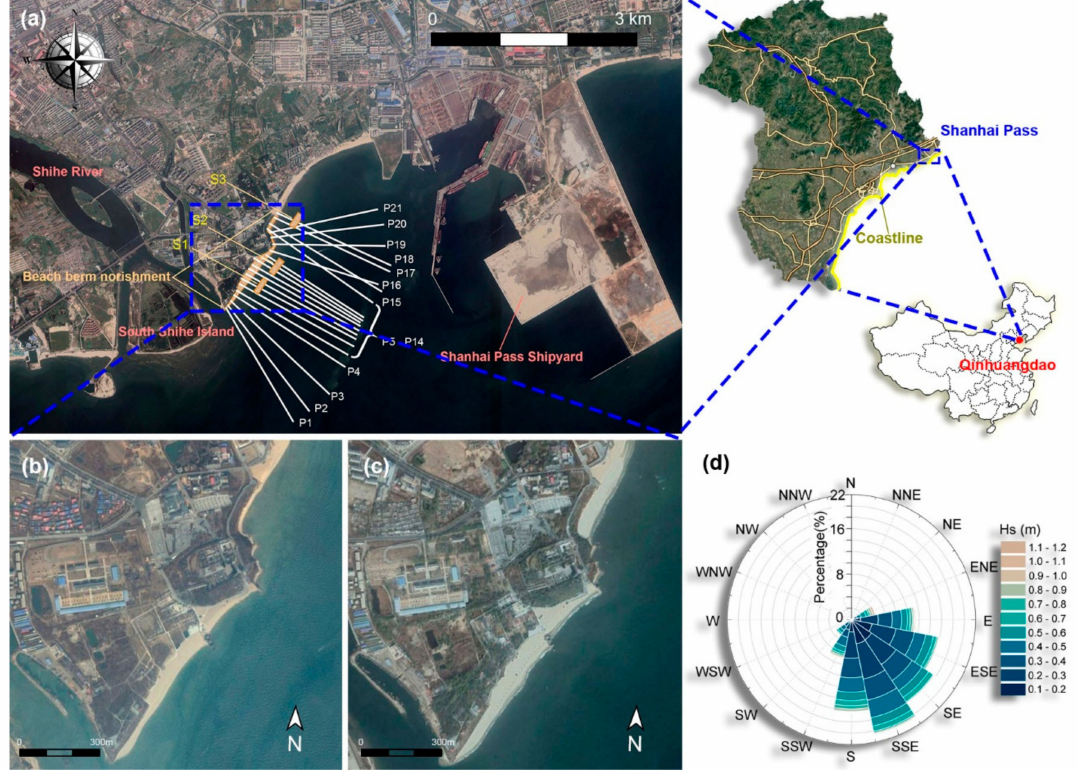
Figure 1. ( a ) Geographic location of the beach nourishment project at the Shanhai Pass, Qinhuangdao, northeastern China with the locations of measured beach profile P1 to P21 (straight white lines) and the submerged sandbars (S1–S3). Aerial photograph ( b ) in March 2017 before beach nourishment and ( c ) in November 2017 after the beach nourishment. ( d ) Directional wave rose during August 2017–July